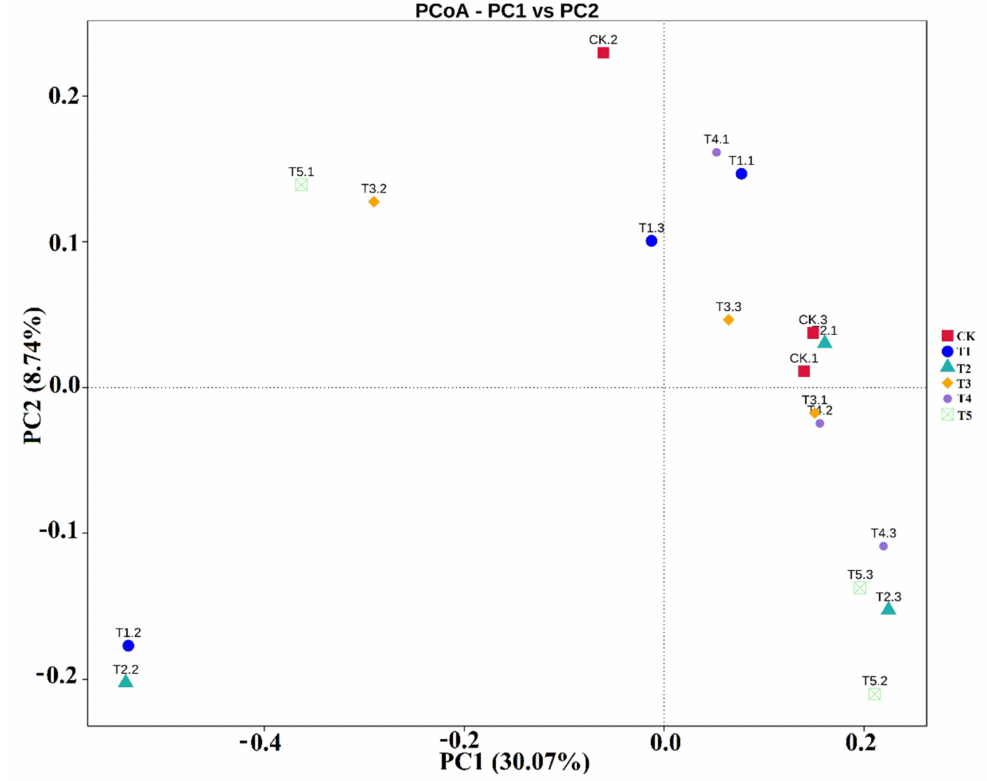
Figure 5. Analysis of beta diversity for estimating similarity or dissimilarity between the genotypes. PCoA (principal coordinate analysis) of weighted UniFrac